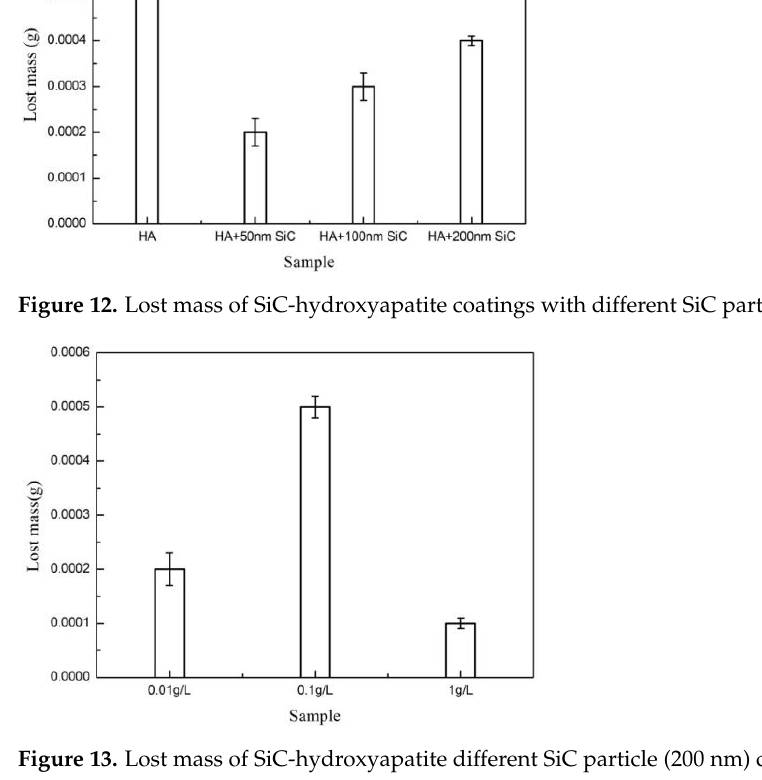
Figure 13. Lost mass of SiC-hydroxyapatite different SiC particle (200 nm) concentrations.